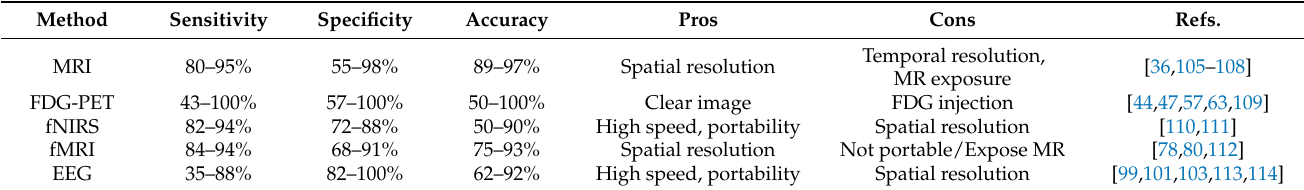
Figure 6. EEG imaging. ( A ) The mechanism of capturing electroencephalogram (EEG) signals and the generation of EEG network oscillations. Adapted from [94] with permission from Elsevier. ( B ) The functional networks of AD and control groups in six frequency bands. Adapted from [102] with permission from AIP Publishing. ( C ) Microstate topographies of healthy older adults (HOA, top row) and AD (bottom row) cohorts. Adapted from [30] with permission from Springer Nature. Table 2. The potential of neuroimaging methods in detecting